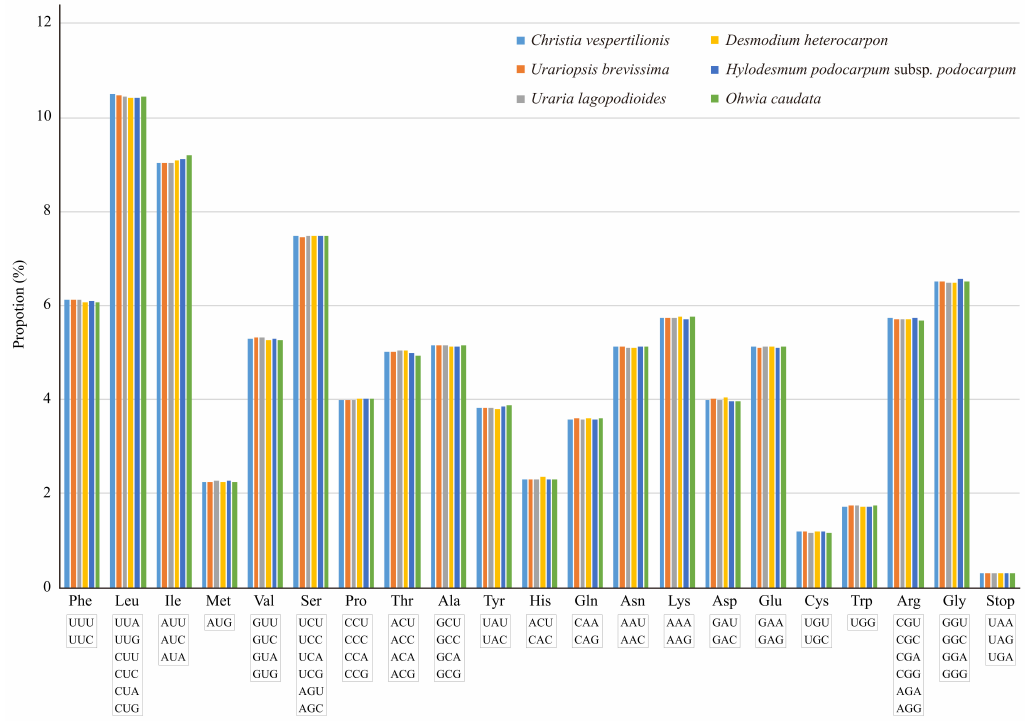
Figure 3. Amino acid frequencies in the protein-coding sequences of six Desmodieae